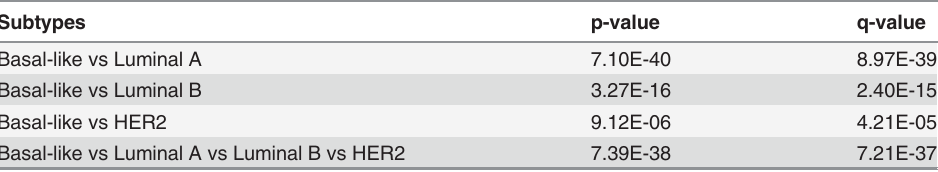
Table 2. mRNA expression of LSD1 in subtypes of breast